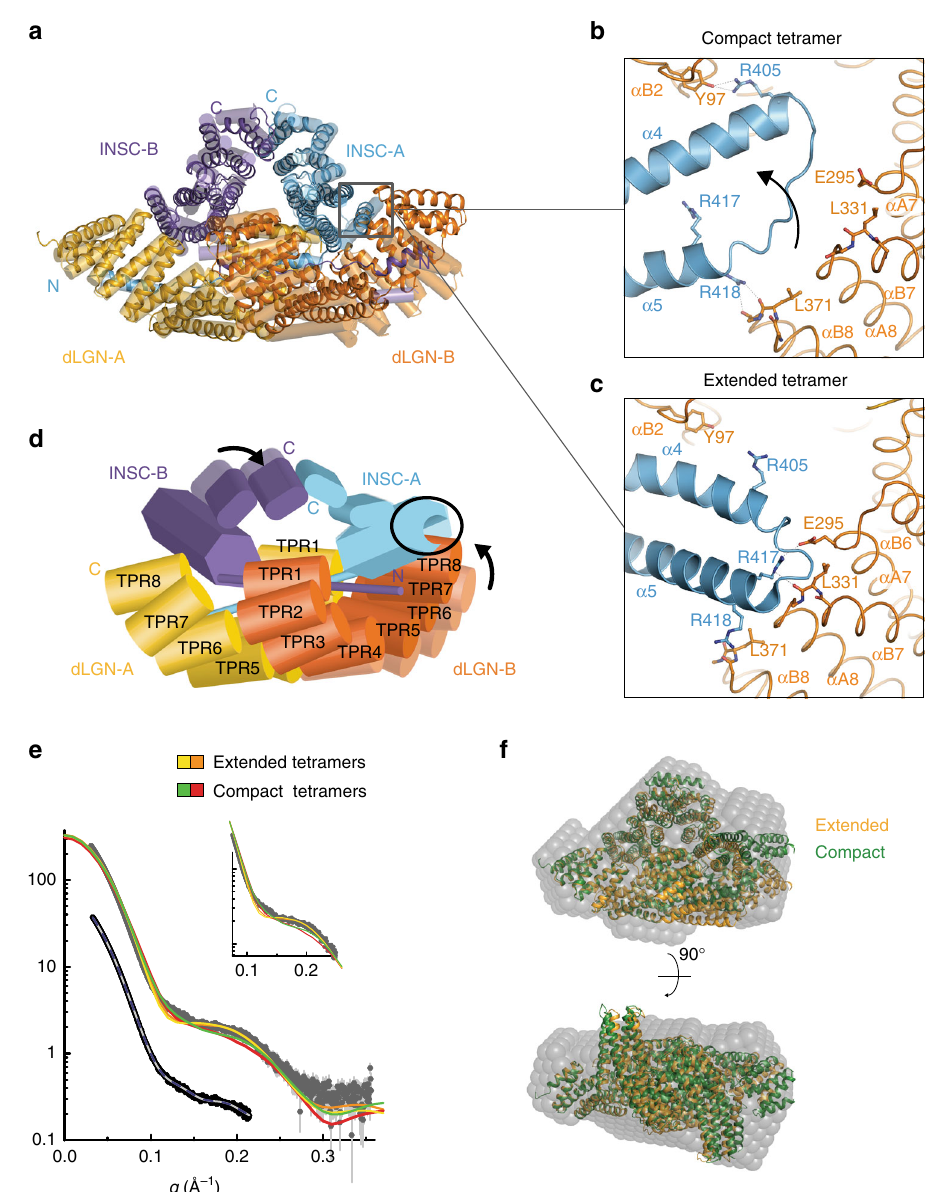
Fig. 2 The dLGN TPR :Insc ASYM complex adopts two conformations. a Superposition of the two dLGN TPR :Insc ASYM conformers present in the a.s.u. The most compact conformer is shown as ribbon diagram, and the most extended is depicted in transparent cylindrical helices. Subunits are colored as in Fig. 1. b , c Zoomed views of the interfaces between the helical bundle of Insc- A and TPR7-8 of dLGN- B for the compact (top) and extended (bottom) tetramers. The rearrangement of the TPR repeats of dLGN-B in the compact conformation is accompanied by disruption of the initial turns of helix α 5 of Insc- A . d Graphical summary of the conformational changes between the extended and the compact tetramers. e SAXS data for the dLGN TPR :Insc ASYM complex in comparison to the theoretical curves for the different con fi gurations (upper part and inlay) and fi ts of ab initio models in P1 (gray) and P2 symmetry (blue). Idealized curves were obtained merging frames with matching radius of gyration and high similarity according to CORMAP 38,39 . f The ab initio model of the dLGN TPR :Insc ASYM complex in P1 symmetry (transparent gray spheres) matches well with both the extended (orange) and compact (green) tetramer hull, the symmetrical interface between dLGN- A TPR and an abrupt kink to form the fi rst helix of the bundle (the α 3 helix of Insc ASYM , Fig. 1a), running almost orthogonal to the dLGN- A dLGN- B TPR is contributed primarily by hydrogen bonds between TPR repeats. Compared to the extensive contacts engaging the main chain atoms of TPR turns, as exempli fi ed at TPR4-5 Insc PEPT , fewer speci fi c interactions are found in the rest of the (Supplementary Fig. 3a, b). The corresponding interface at the tip interface between Insc and dLGN molecules. A cluster of Gln of the sails is maintained by pairing of the α 3-helices of the third residues in the middle of the α 3 helix of Insc- A ASYM packs Armadillo repeats via hydrophobic interactions between against the intra-repeat loops of the TPR1-2 dLGN-B making Val585 Insc and Ala589 Insc of both chains, further strengthened bidentate hydrogen bonds with main chain atoms and staking by a polar interaction between Arg582 Insc-A and Gln590 Insc-B interactions with Tyr93 dLGN-B (Fig. 1g). These contacts create a (Fig. 1h and Supplementary Movie 1). Thus, based on structural topological closure of the TPR channel. In the center of the evidence, we can conclude that (1) the dLGN TPR :Insc ASYM is a